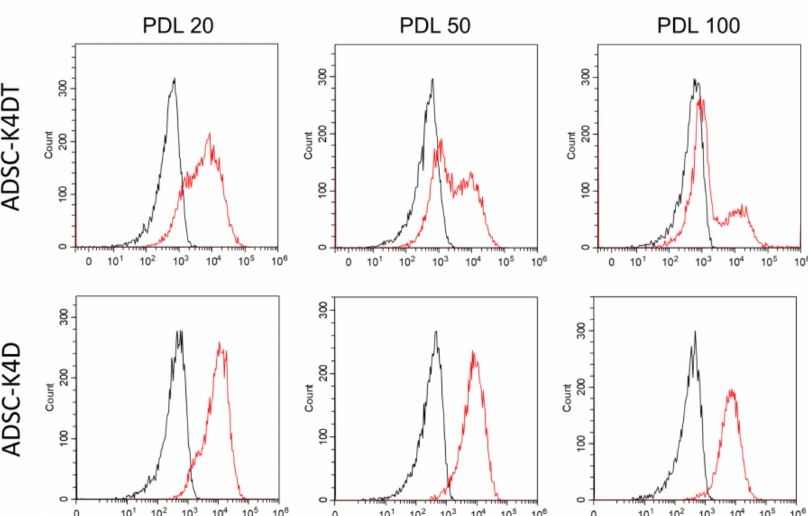
Figure 4. Changes in CD90 expression in the ADSC-K4DT and ADSC-K4D cells. CD90 expression in both cell lines at low (approximately PDL 20), intermediate (approximately PDL 50), and high (approximately PDL 100) PDs is shown. Black lines represent isotype controls, and red lines indicate each cell line. CD90 expression in the ADSC-K4DT cells decreased gradually in accordance with cell division, but that in the ADSC-K4D cells was maintained after repeated cell